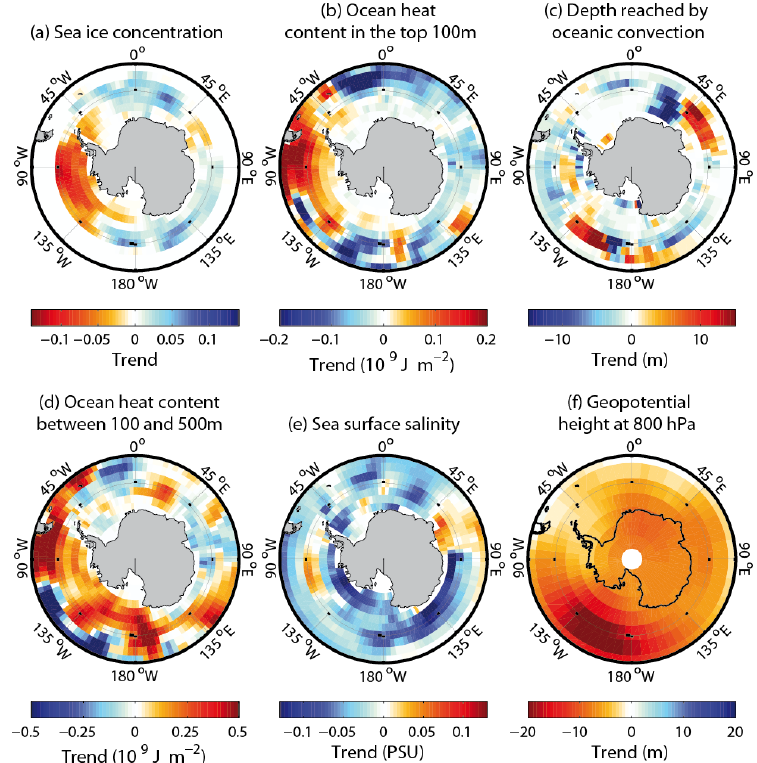
Fig. 10. Trends over the period 1979–2009 in a simulation with LOVECLIM using data assimilation scaled to represent the 31 year changes of (a) ice concentration, (b) ocean heat content in the top 100m (Jm − 2 ) , (c) depth reached by oceanic convection (m), (d) ocean heat content Figure 10. Trends over the period 1979-2009 in a simulation with LOVECLIM using data assimilation in the layer between 100 and 500m (Jm − 2 ) , (e) sea surface salinity, and (f) geopotential height at 800hpa scaled to represent the 31 year changes of a) ice concentration, b) ocean heat content in the top 100 m (Jm -2 ), c) depth reached by oceanic convection (m), d) ocean heat content in the layer between 100 and 500 m (Jm -2 ), e) sea surface salinity, f) geopotential height at 800 hpa (m).